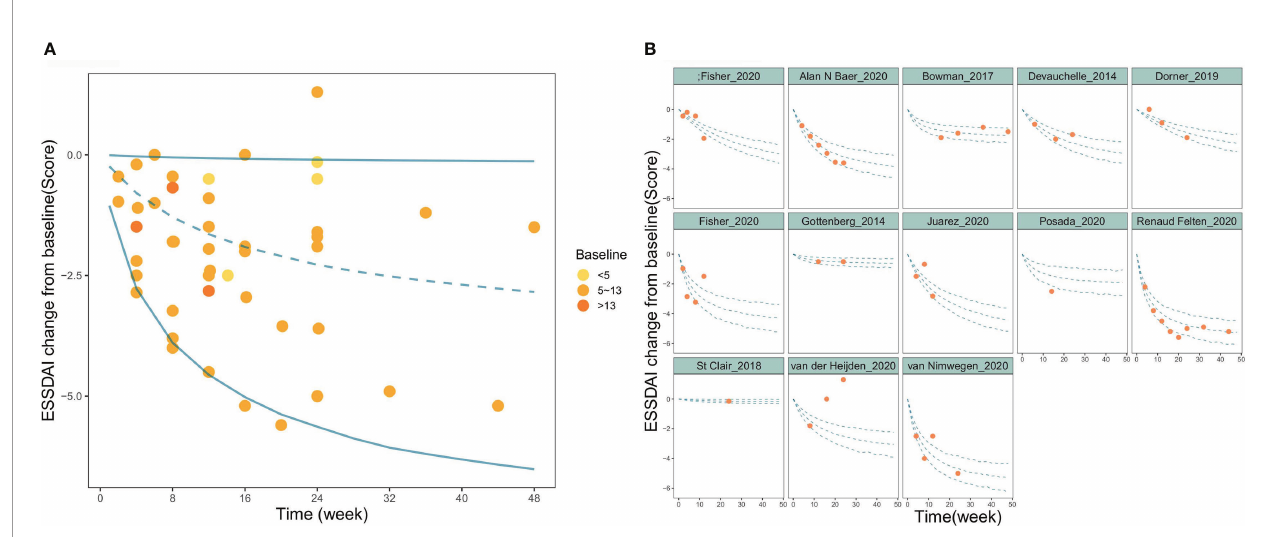
FIGURE 2 | Visual predictive check of the fi nal model. (A) Time course of PSS change from baseline for overall study. (B) Time course of PSS change from baseline for each individual study. The blue lines in the fi gure represent the 2.5%, 50%, and 97.5% percentiles of the placebo response predicted by the model, respectively, and the points represent the observed